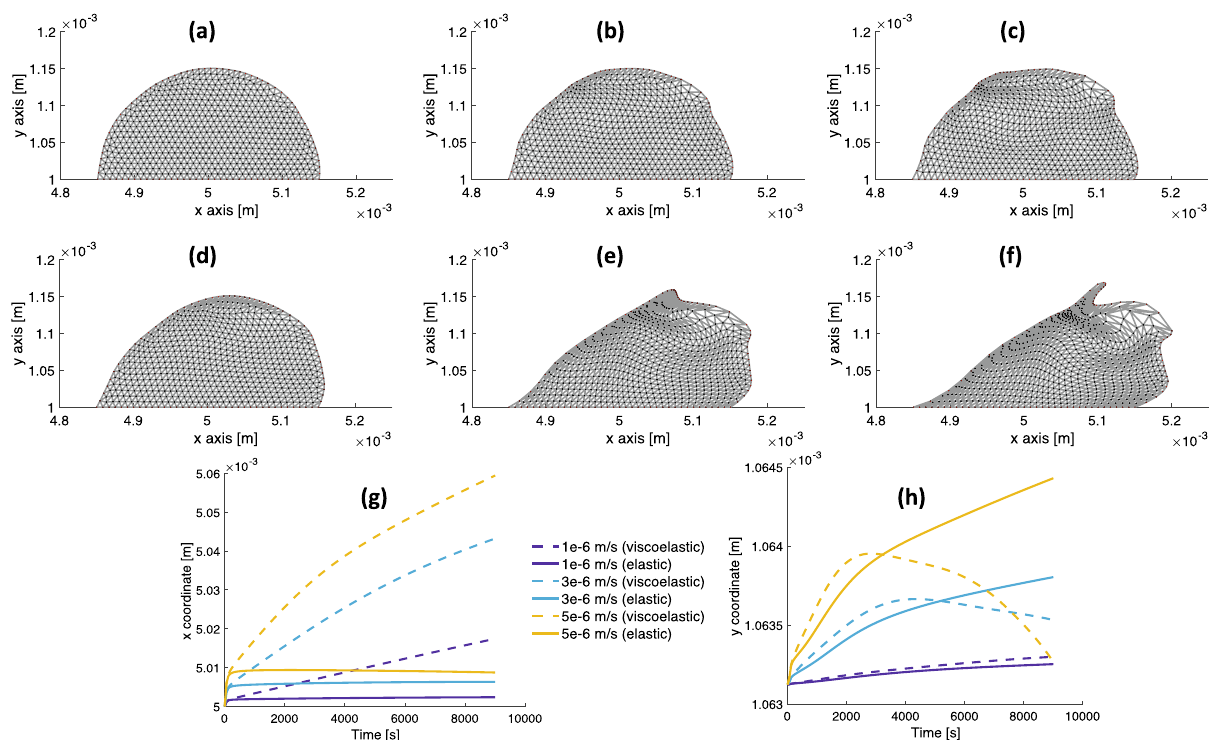
Figure 2. Comparison of deformation in shear flow between an elastic biofilm ( E = 50 Pa) and a viscoelastic biofilm ( E = 50 Pa, η = 5 × 10 4 Pa.s). ( a )–( f ) From top to bottom: elastic to viscoelastic; from left to right: u max = 1, 3, 5 × 10 − 6 m/s. Protrusions appear in viscoelastic biofilm at flow rates that are absent in the elastic biofilm. ( g ) The x -coordinate of center of mass versus time. The x -coordinate of the viscoelastic biofilm continues to increase in time as the dashpots in the Maxwell elements continue to increase in length. The x -coordinate of the elastic biofilm reaches equilibrium when the springs in the Stokes elements reach equilibrium. ( h ) The y -coordinate of center of mass versus time. Relative to the change in the x -coordinate, the change of the y -coordinate is an order of magnitude smaller, indicating the flow acts primarily to shear the